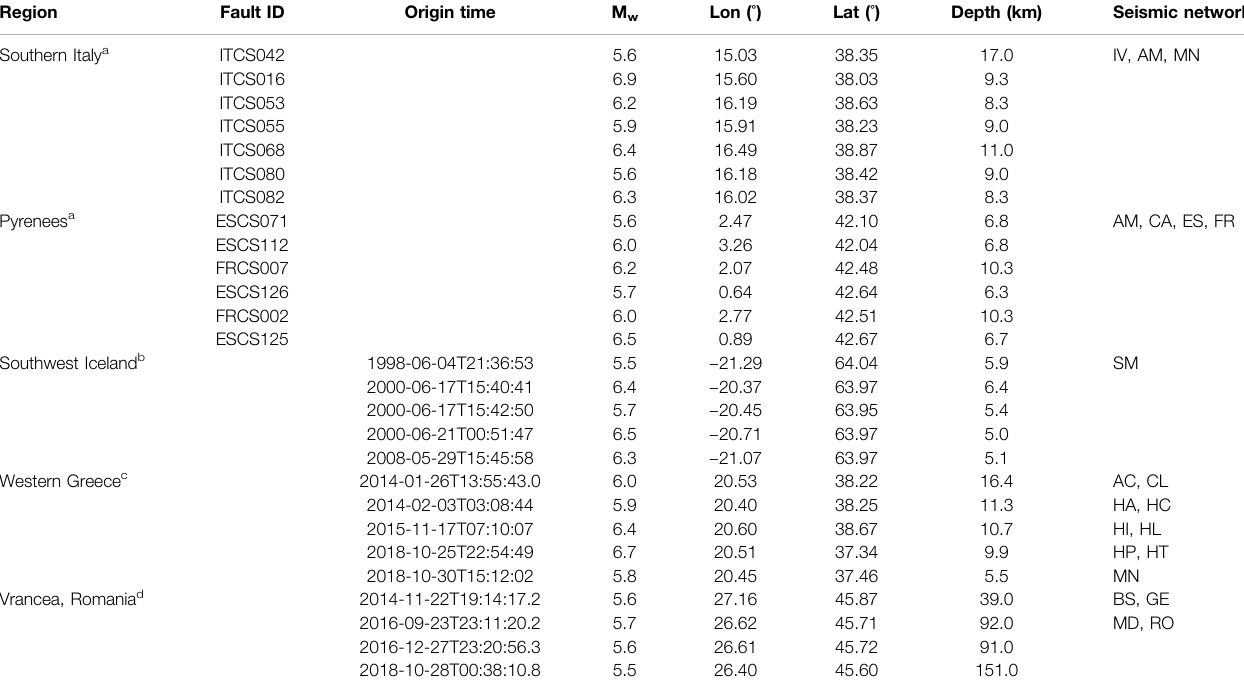
TABLE 2 | Magnitude, longitude, latitude, and depth of the events considered in this study (retrieved from the seismological agencies provided in the table footnote), along with the seismic networks used in each region. Region